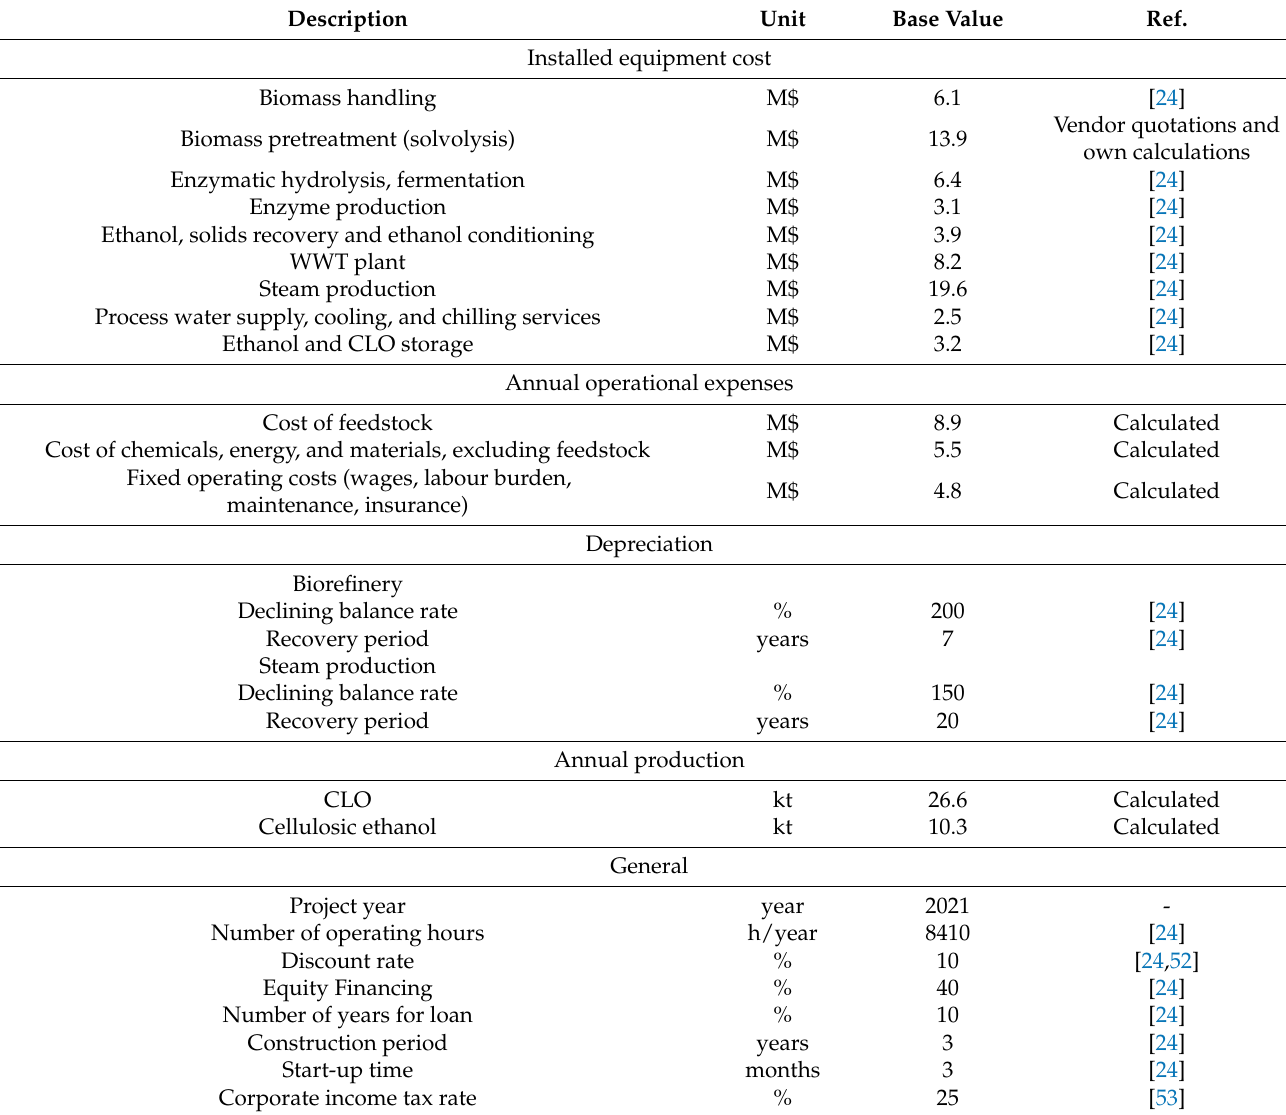
Table A4. Inputs to economic